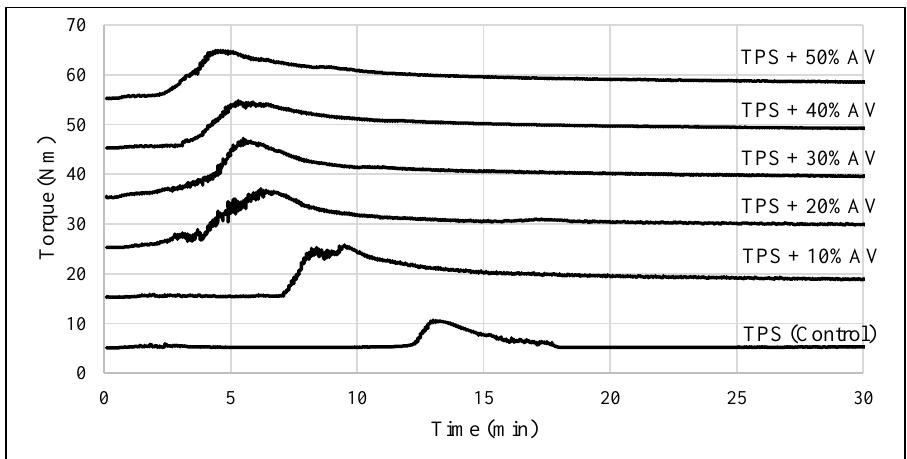
Figure 1. The torque value of TPS film with different AV gel concentrations.